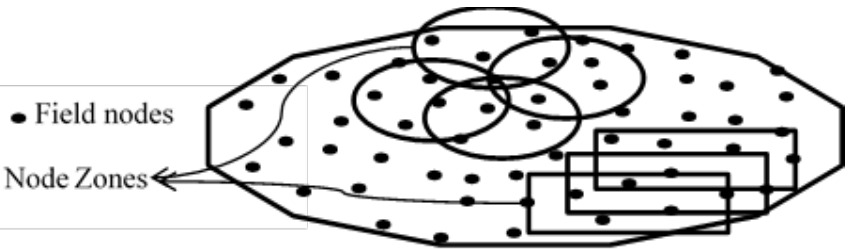
Figure 2. Mesh free node zones (Circular/Rectangular) for RPI bases recovery technique.